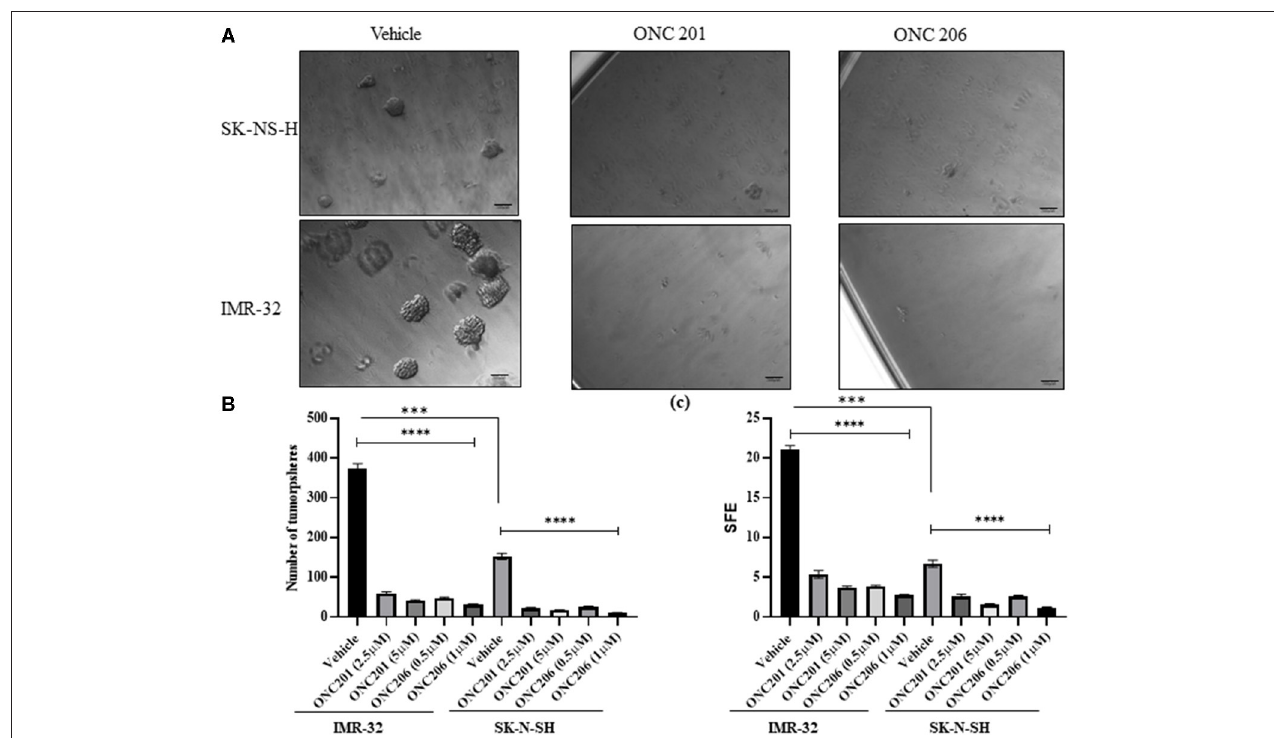
FIGURE 6 | Stem-cell tumorsphere self-renewal potential after ONC201/ONC206 treatment. SK-N-SH and IMR-32 cells treated with ONC201 (2.5 or 5 µ M) or ONC206 (0.5 or 1 µ M) exhibited a significant inhibition in the tumorsphere formation potential compared with vehicle-treated cells as assessed using the sphere formation efficiency (SFE) assay. IMR-32 cells exhibited a statistically significant higher rate of SFE compared with SK-N-SH cells. The representative micrographic images (A) , sphere numbers (B) , and SFE (C) illustrate the significant reduction in tumorsphere formation potential in both cell lines after drug treatment. Experiments were conducted in triplicates and repeated three times. Data represent the mean ± the standard error of the mean (SEM) of multiple experiments. **** p < 0.0001. ***Statistical significance <